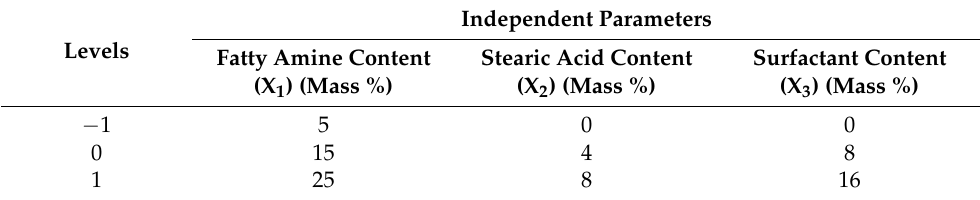
Table 1. Levels and independent factors for the composition of anti-caking agents. Independent Parameters Levels Fatty Amine